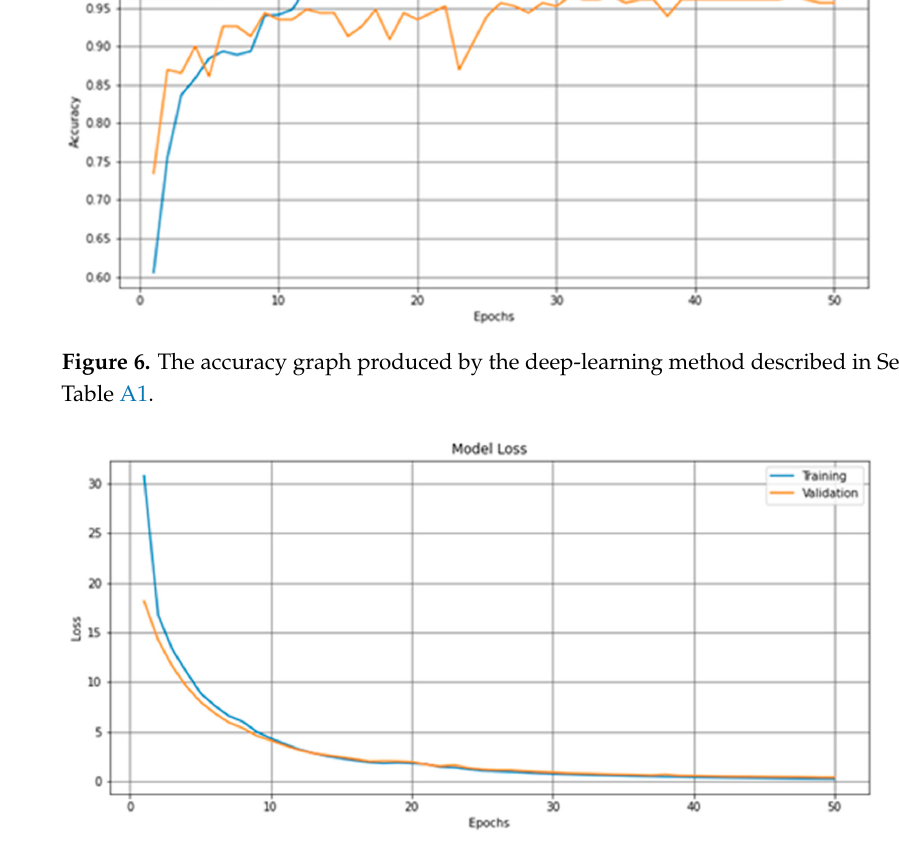
Table A1. Table A1.